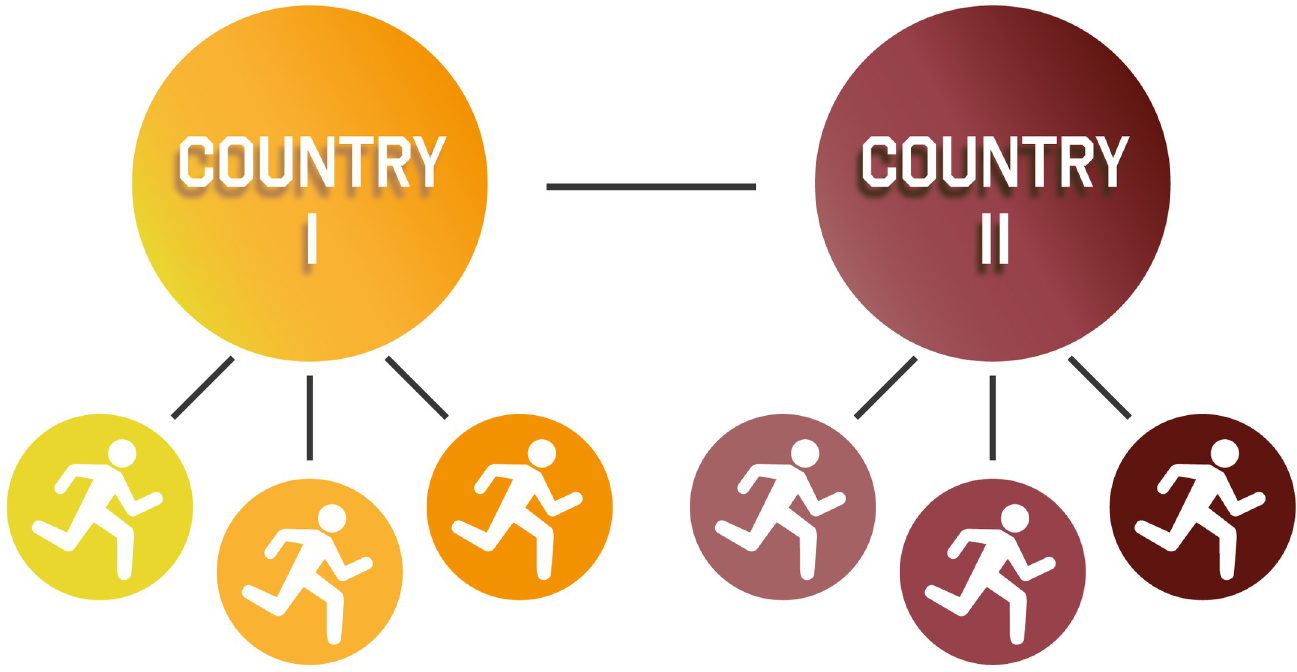
Fig 2. InTrack project data